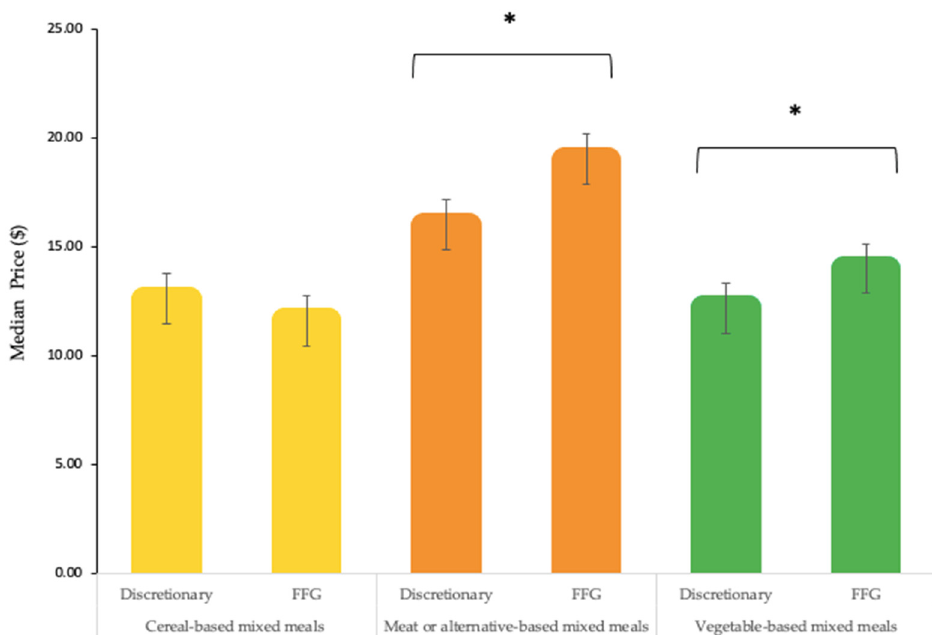
Figure 2. Median price (in NZD) of all discretionary and Five Food Group (FFG) mixed meal menu items excluding catering and party packs, value bundles, combination menu items and menu items with price unavailable. All menu items include regular menu items and popularized menu items. Error bars display interquartile interval, * p < 0.001.